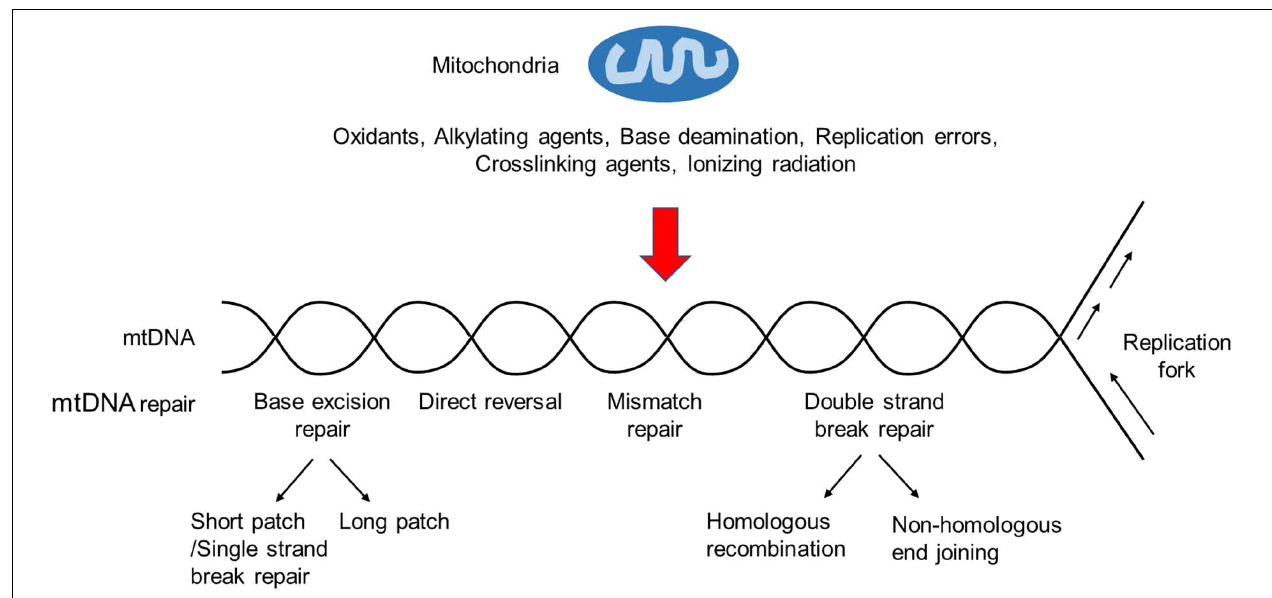
FIGURE 1 | An overview of the mtDNA damage repair. Ionizing radiation, base deamination, replication errors, and DNA damaging agents, such as oxidants, alkylating agents, and crosslinking agents, can cause mtDNA damages. BER is the primary mtDNA damage repair pathway, whereas NER is not observed in mitochondria. In addition, other repair pathways, such as DR, MMR and DSBR, may exist in the mitochondria.